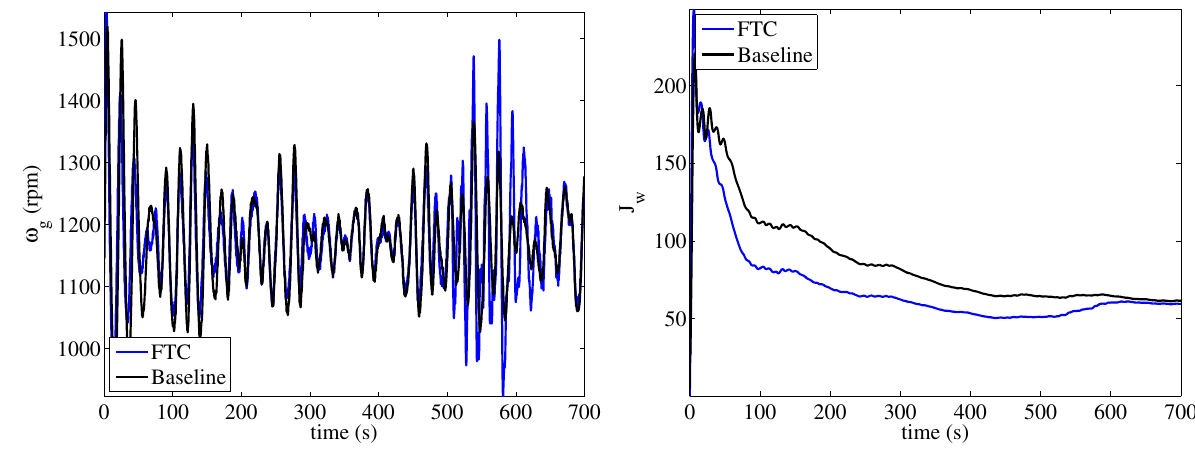
Figure 6. Generator speed ( left ) and J